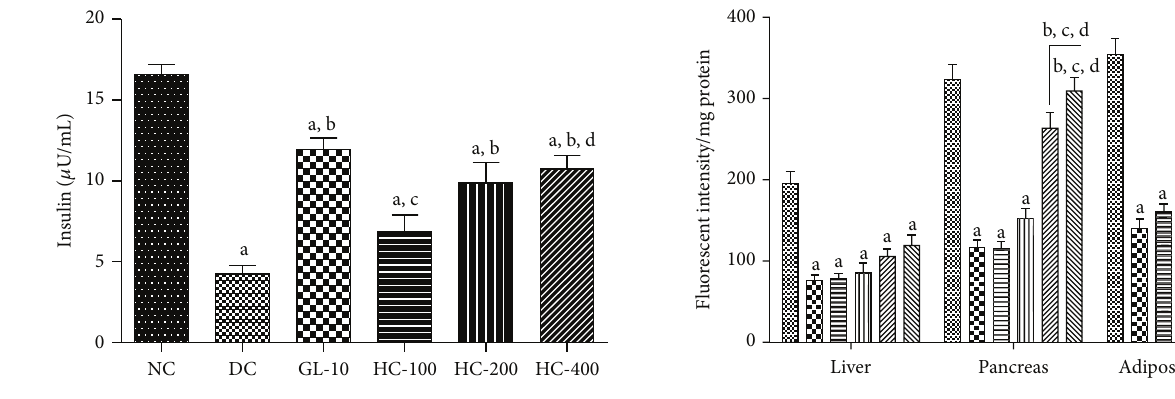
Figure 2: Effect of HC on plasma Insulin levels in control and experimental rats. Values are given as mean ± SD, 𝑛 = 6 , a 𝑃 < 0.05 compared to normal control; b 𝑃 < 0.05 compared to diabetic control; c 𝑃 < 0.05 compared to glibenclamide; d 𝑃 < 0.05 comparedtoHC100(one-wayANOVAfollowedbyTukey’smultiple comparison test).